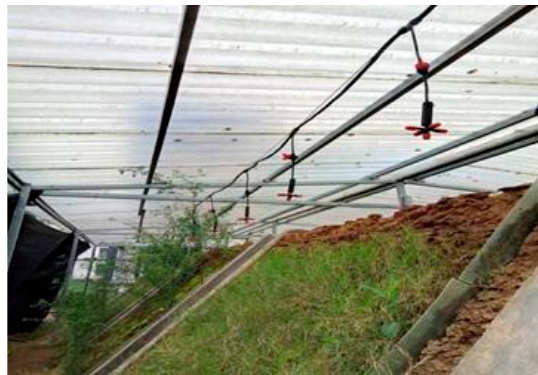
Figure 1. Experimentally simulated slope.